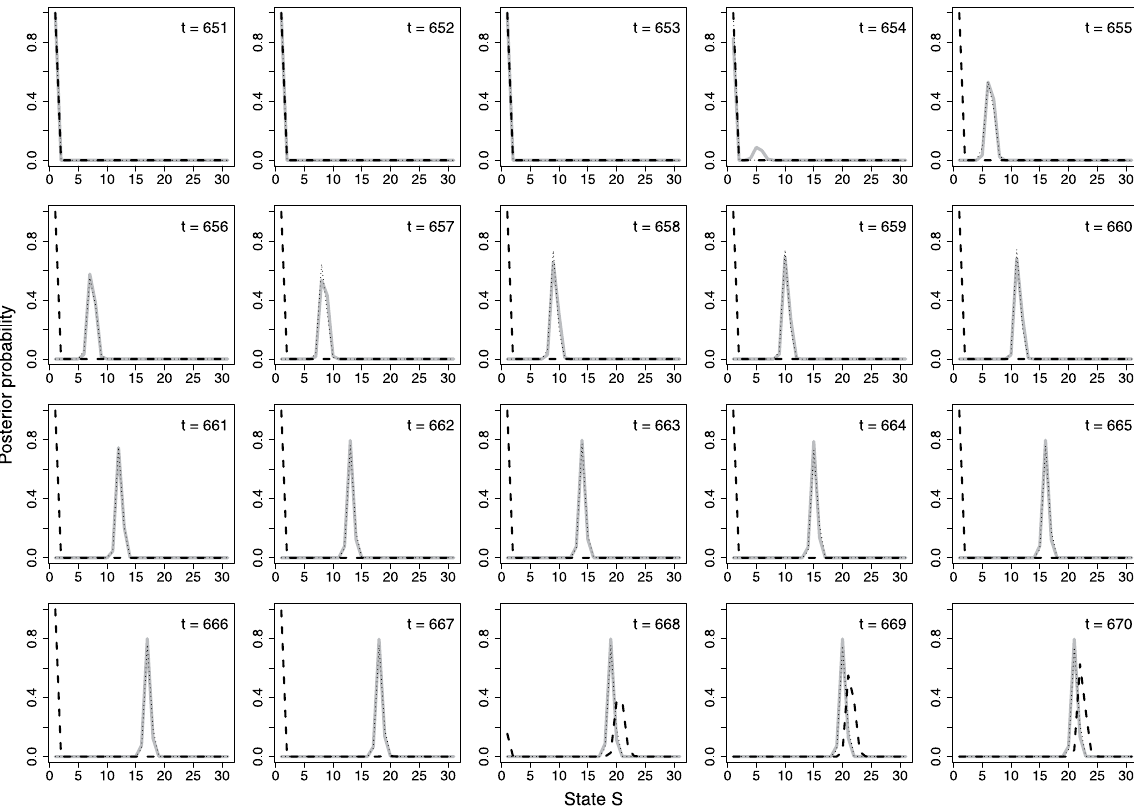
Figure 4. Posterior probability of being in state S (0–30) at a given day of observation (t) for the three scenarios no delay (grey solid line), delay aware (black dotted line) and delay non-aware (black dashed line). Twenty days of observation, starting on the first day of outbreak, were chosen to illustrate the transition of the system from baseline to outbreak